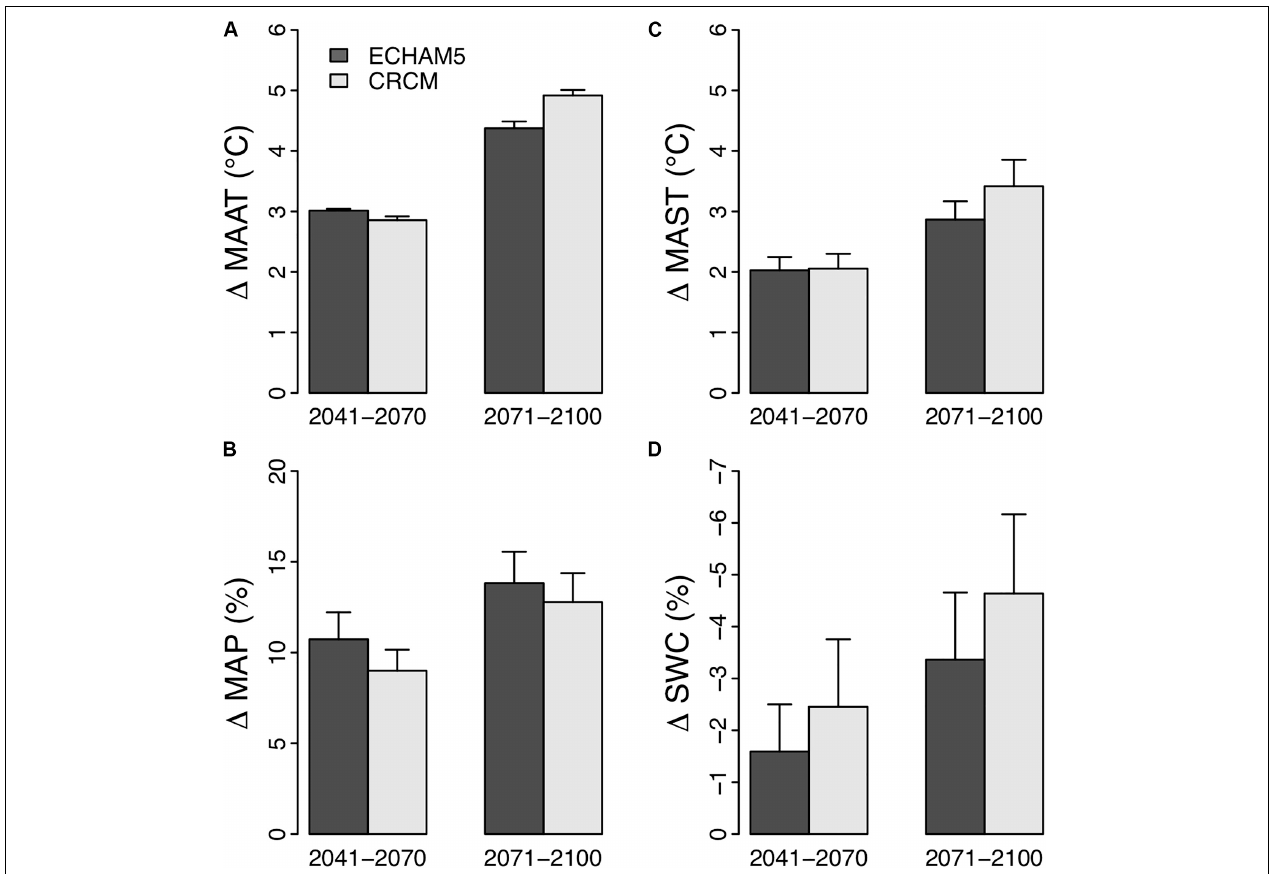
FIGURE 2 | Changes in mean annual air temperature (MAAT) (A) , mean annual precipitation (MAP) (B) , mean annual soil temperature (MAST) (C) and soil water content (SWC) (D) between the reference period (1971–2000) and the 2041–2070 and 2071–2100 periods. MAAT and MAP values were projected by the ECHAM 5 (global) and CRCM (regional) climate models and were used as inputs in the FORHYM-FORSTEM model for MAST and SWC projections.